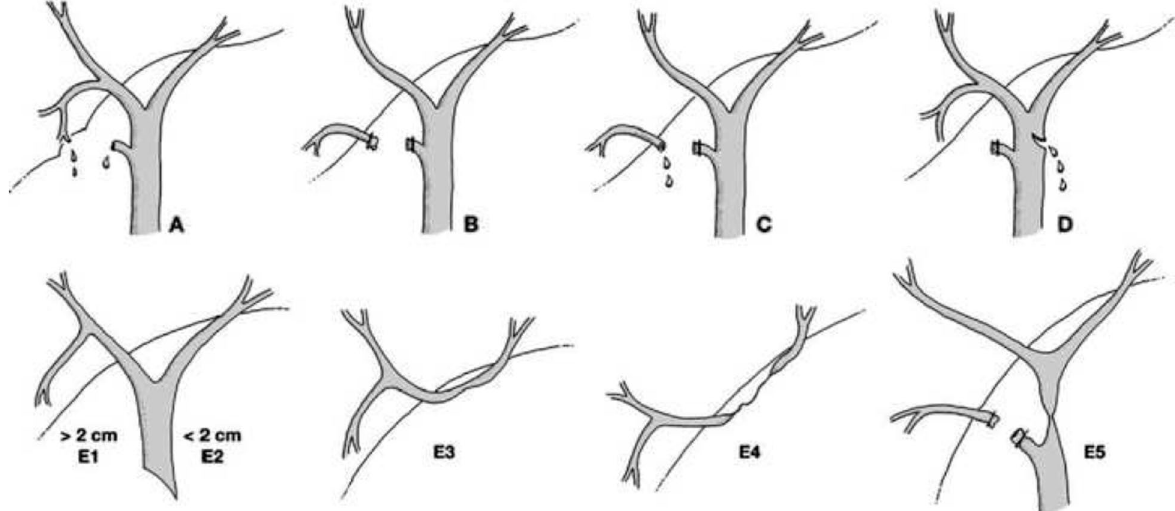
Fig. 1 Drawings show the Strasberg system for classifying bile duct